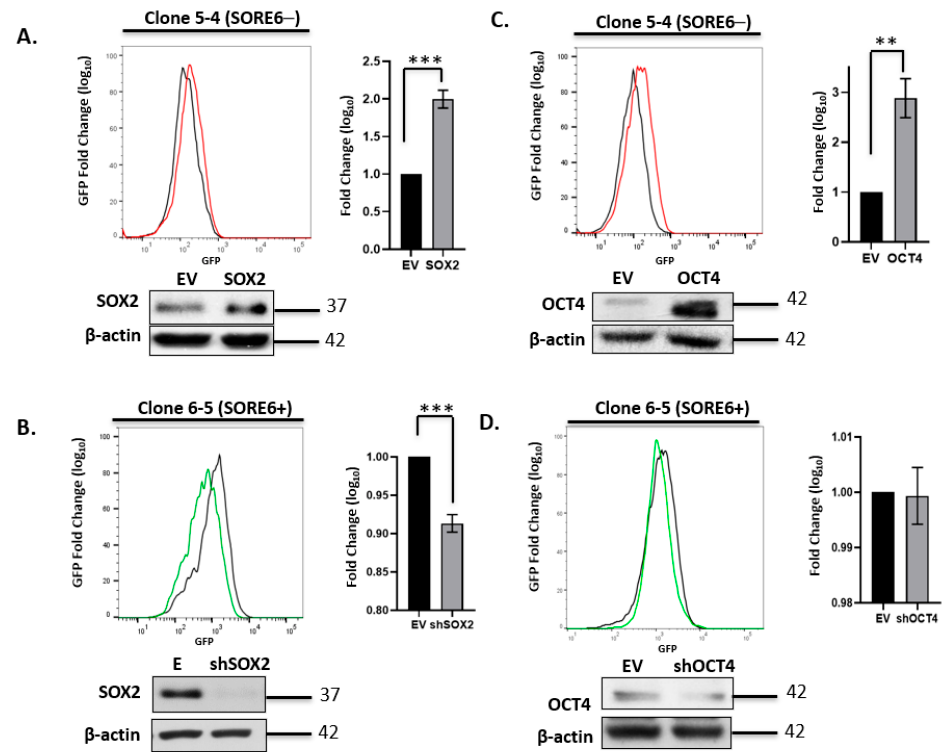
Figure 3. Experimental manipulation of Sox2 and Oct4 in SupM2 SORE6 clones. ( A ) FACS analysis showing the effect on SORE6 reporter activity of overexpressing Sox2 in single-cell clone 5-4 (SupM2 SORE6 − ). ( B ) FACS analysis showing the effect on SORE6 reporter activity of overexpressing shSox2 in single-cell clone 6-5 (SupM2 SORE6+). ( C ) FACS analysis showing the effect of Oct4 downregulation on SORE6 reporter activity in clone 5-4 (SupM2 SORE6 − ). ( D ) FACS analysis showing the effect of shOct4 transfection on SORE6 reporter activity in single-cell clone 6-5 (SupM2 SORE6+). All results shown are representative of three independent experiments and were also repeated in a second batch of single-cell clones. Side panels show the fold change of GFP in log scale (mean ± SEM). Bottom panels of each figure are the Western blots showing the effect of transient transfection with Sox2, Oct4, shSox2, and shOct4 plasmids. Empty vector (EV) was included as a negative control. ** p < 0.01, *** p <